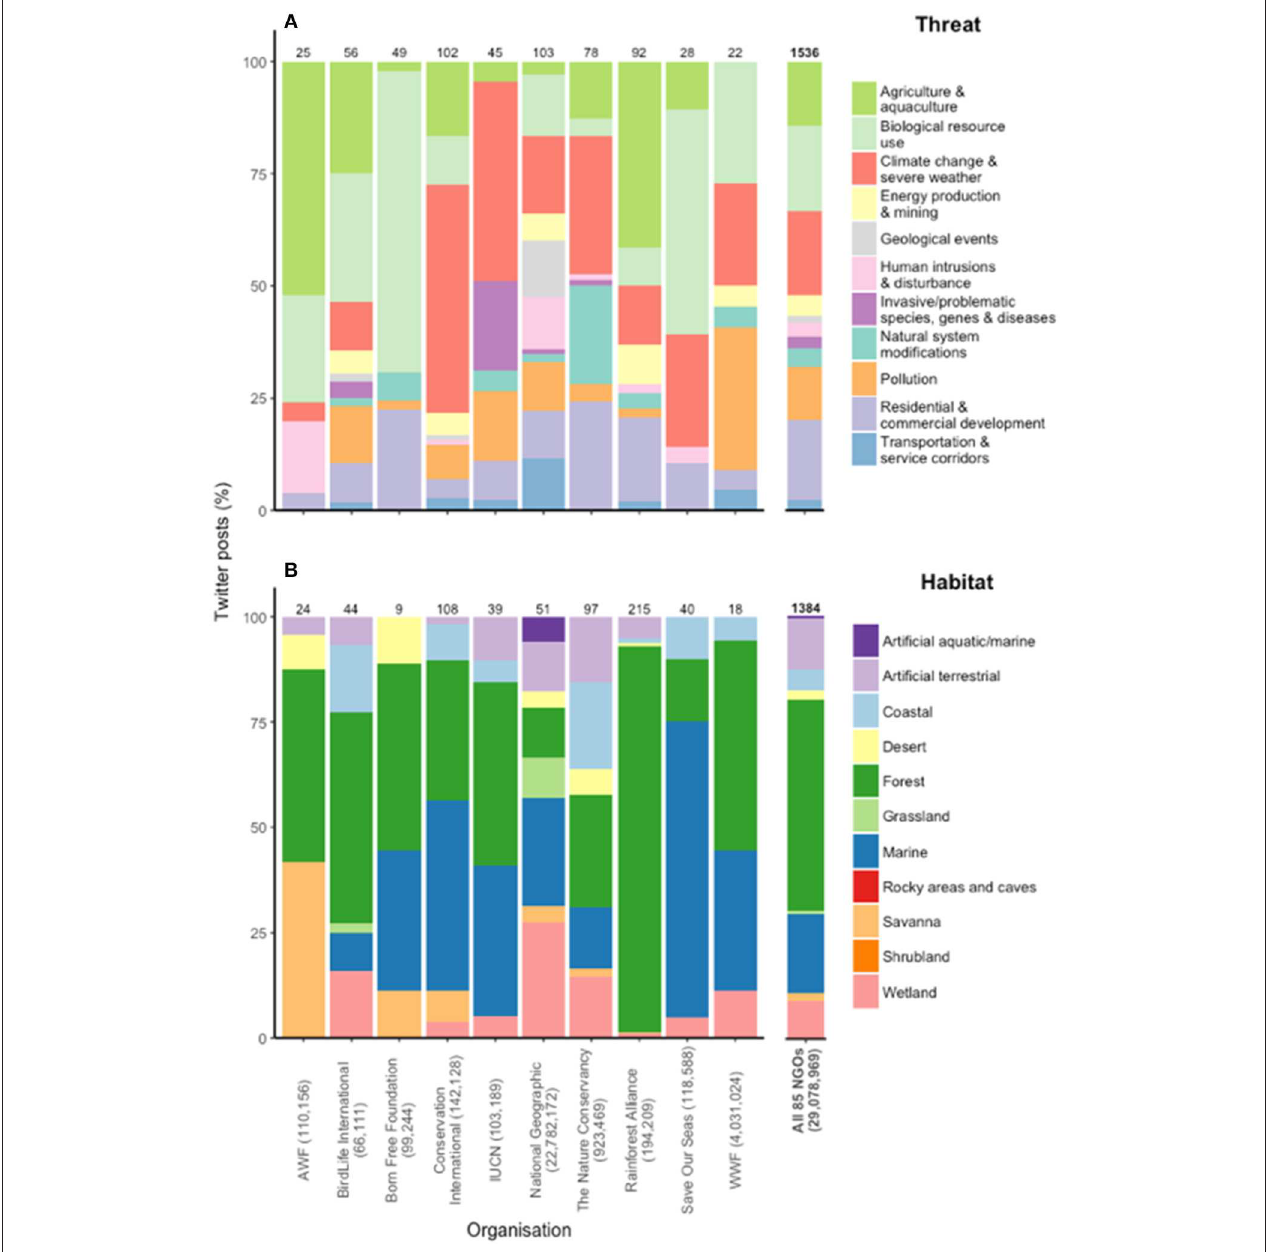
FIGURE 3 | Twitter posts on Red List Threats and Habitats. Twitter posts allocated to a specific Threat (A) or Habitat (B) contained at least one keyword corresponding to the Threat or Habitat. The right-hand bars are a total from the 85 international NGOs with Twitter profiles who are members of the IUCN. The left-hand bars are the top 10 most followed NGOs of the 85. Data are from 150 days between 31/12/2017 and 29/05/2018, and the number of posts is shown on top of the bars for each NGO. The number of followers on 29/05/2018 is shown after each NGO name.